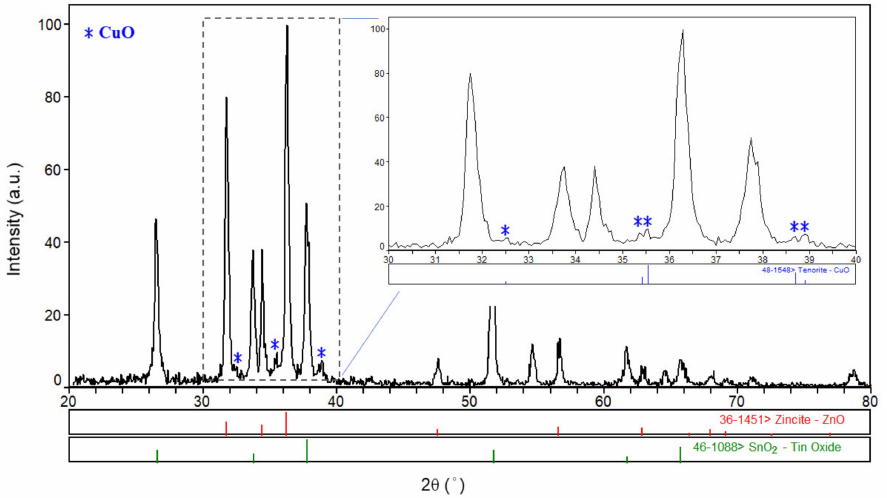
Figure 2. XRD pattern of CuO/ZnO/FTO electrode (CZF-30). The inset depicts the magnified curve for the clearer diffraction peaks of